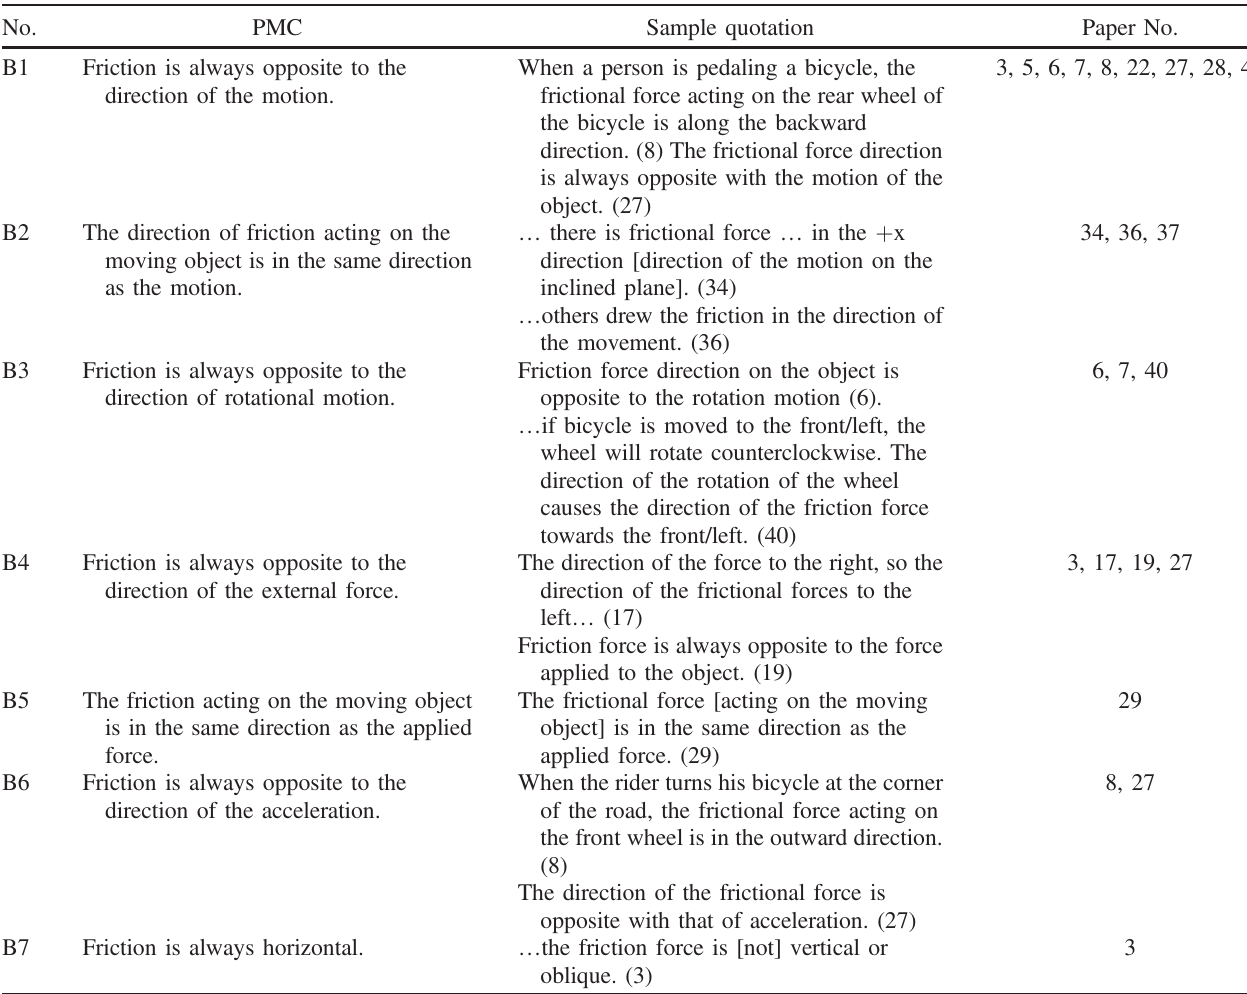
TABLE IV. PMCs related to the direction of